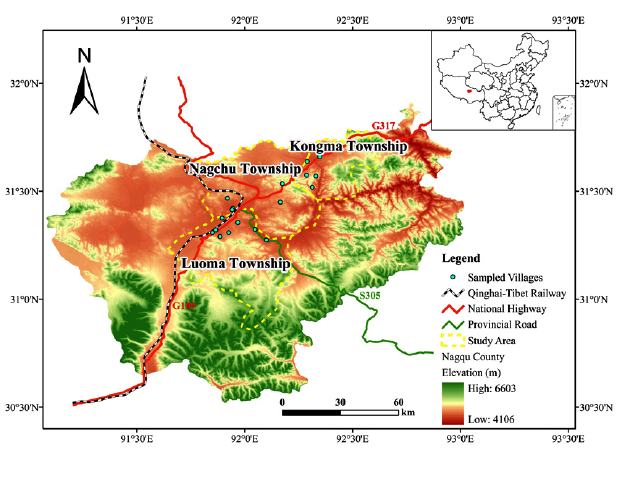
Fig. 1 . Location of the study